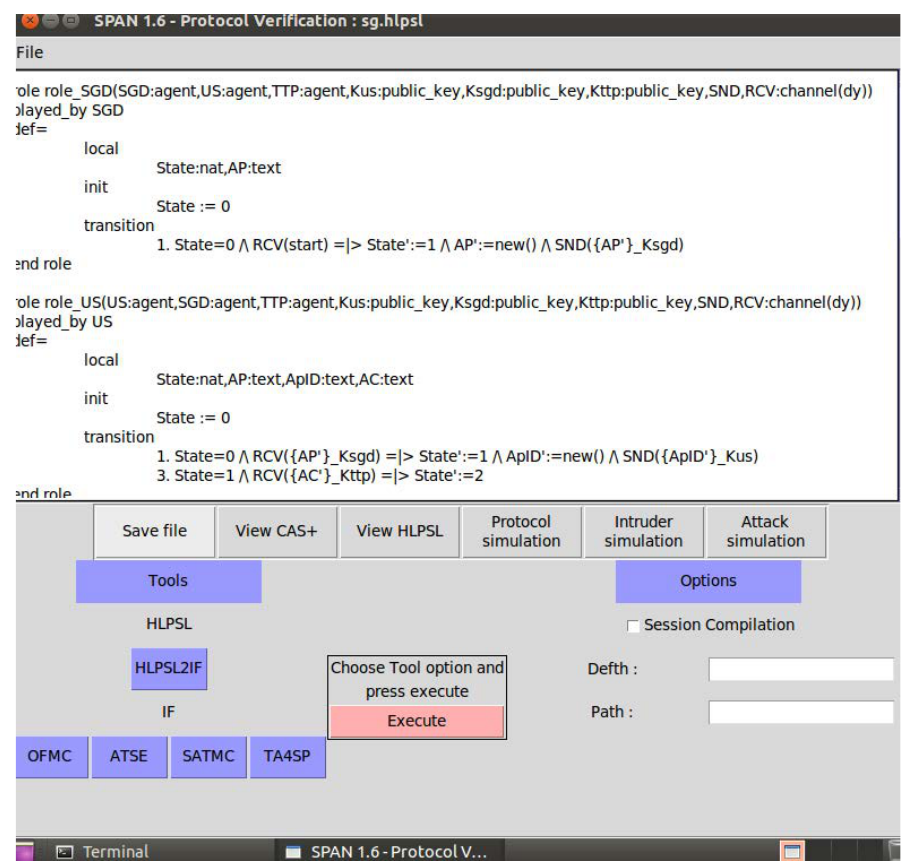
Figure 4. Screen shot of the simulation